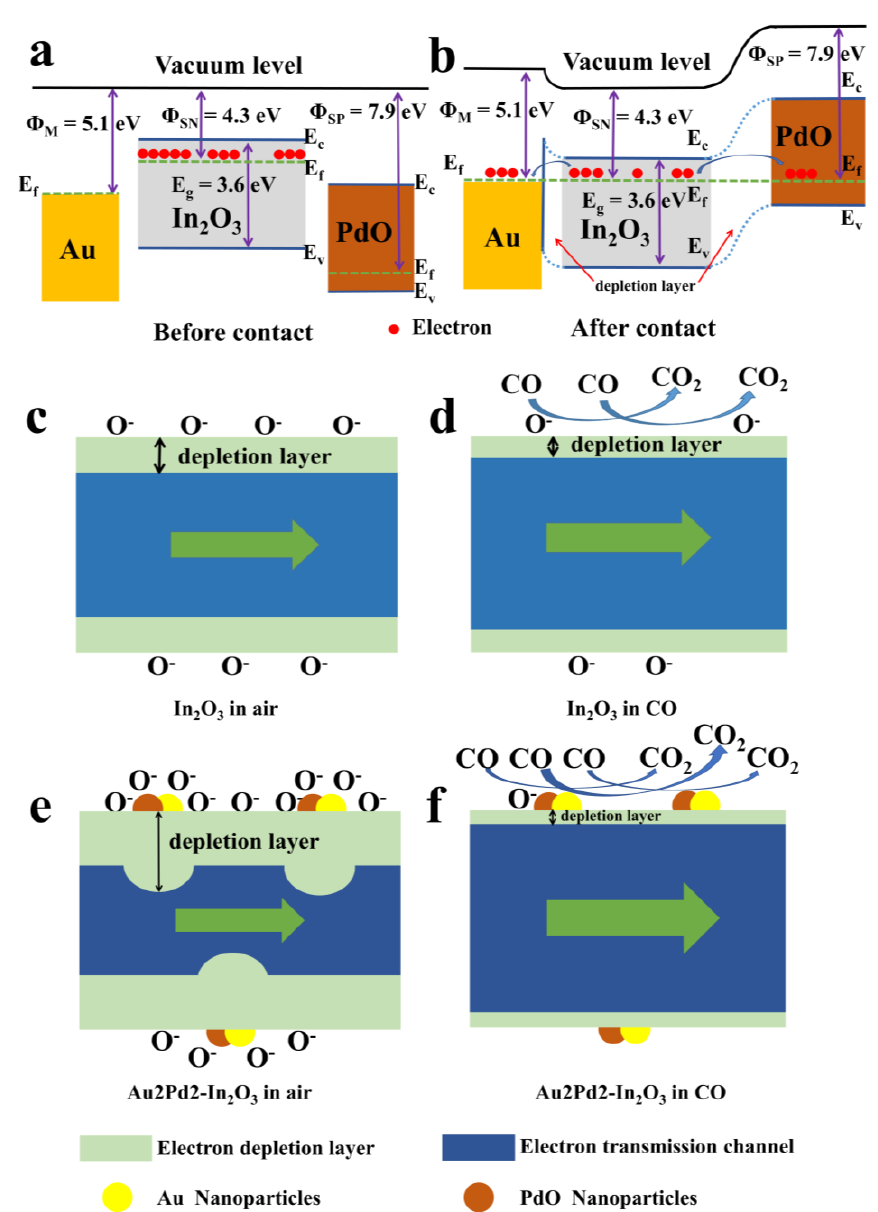
Figure 11. ( a , b ) energy-band diagrams of In 2 O 3 before and after contact with Au and PdO; the schematic illustration of the sensing mechanism for ( c , d ) pure In 2 O 3 and ( e , f ) Au2Pd2-In 2 O 3 nanofibers to CO.